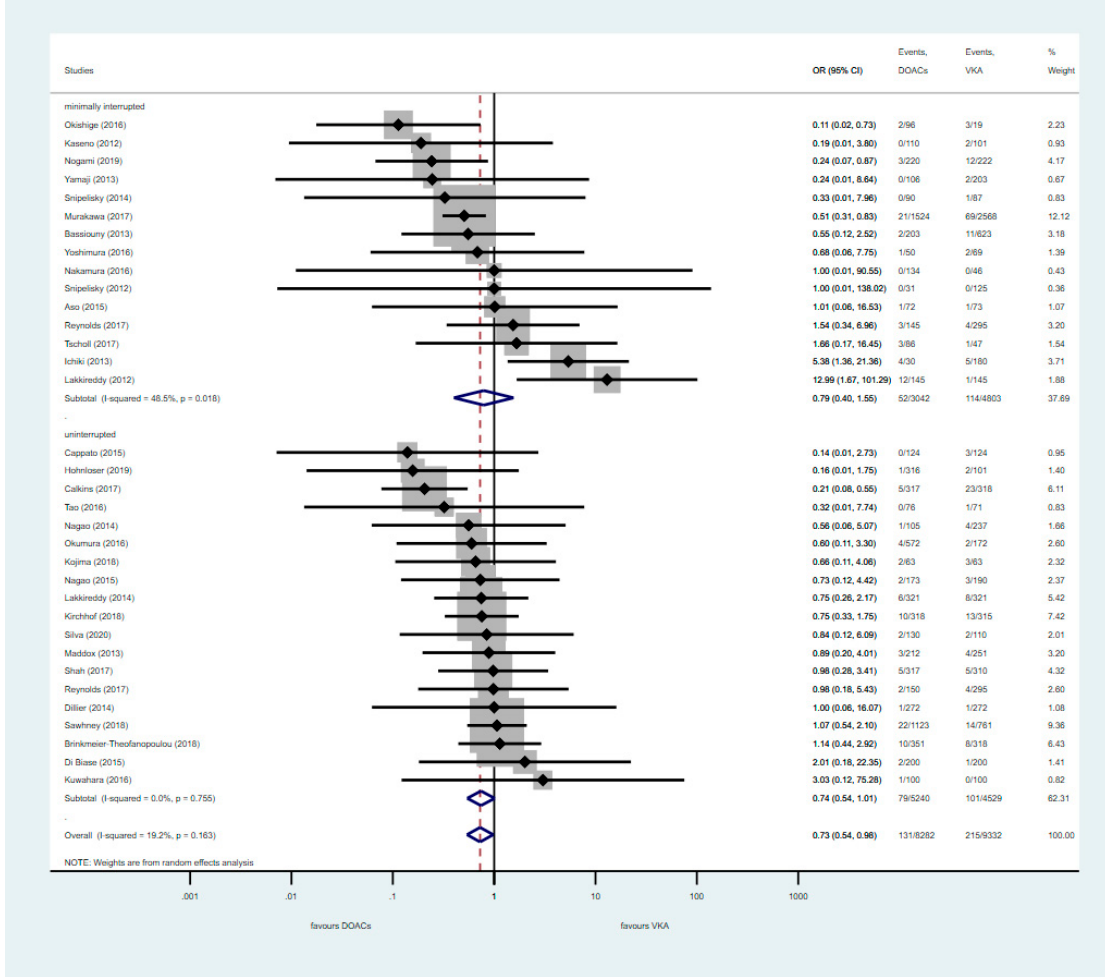
Figure 4. Composite of primary outcomes with uninterrupted or minimally interrupted DOAC strategies vs. VKA. CI: Confidence Interval; OR: Odds Ratio; DOAC: Direct Oral Anticoagulants; VKA: vitamin K antagonist. The diamond defines the overall result of each given group, the dotted red line is there to graphically show the overall results of the groups